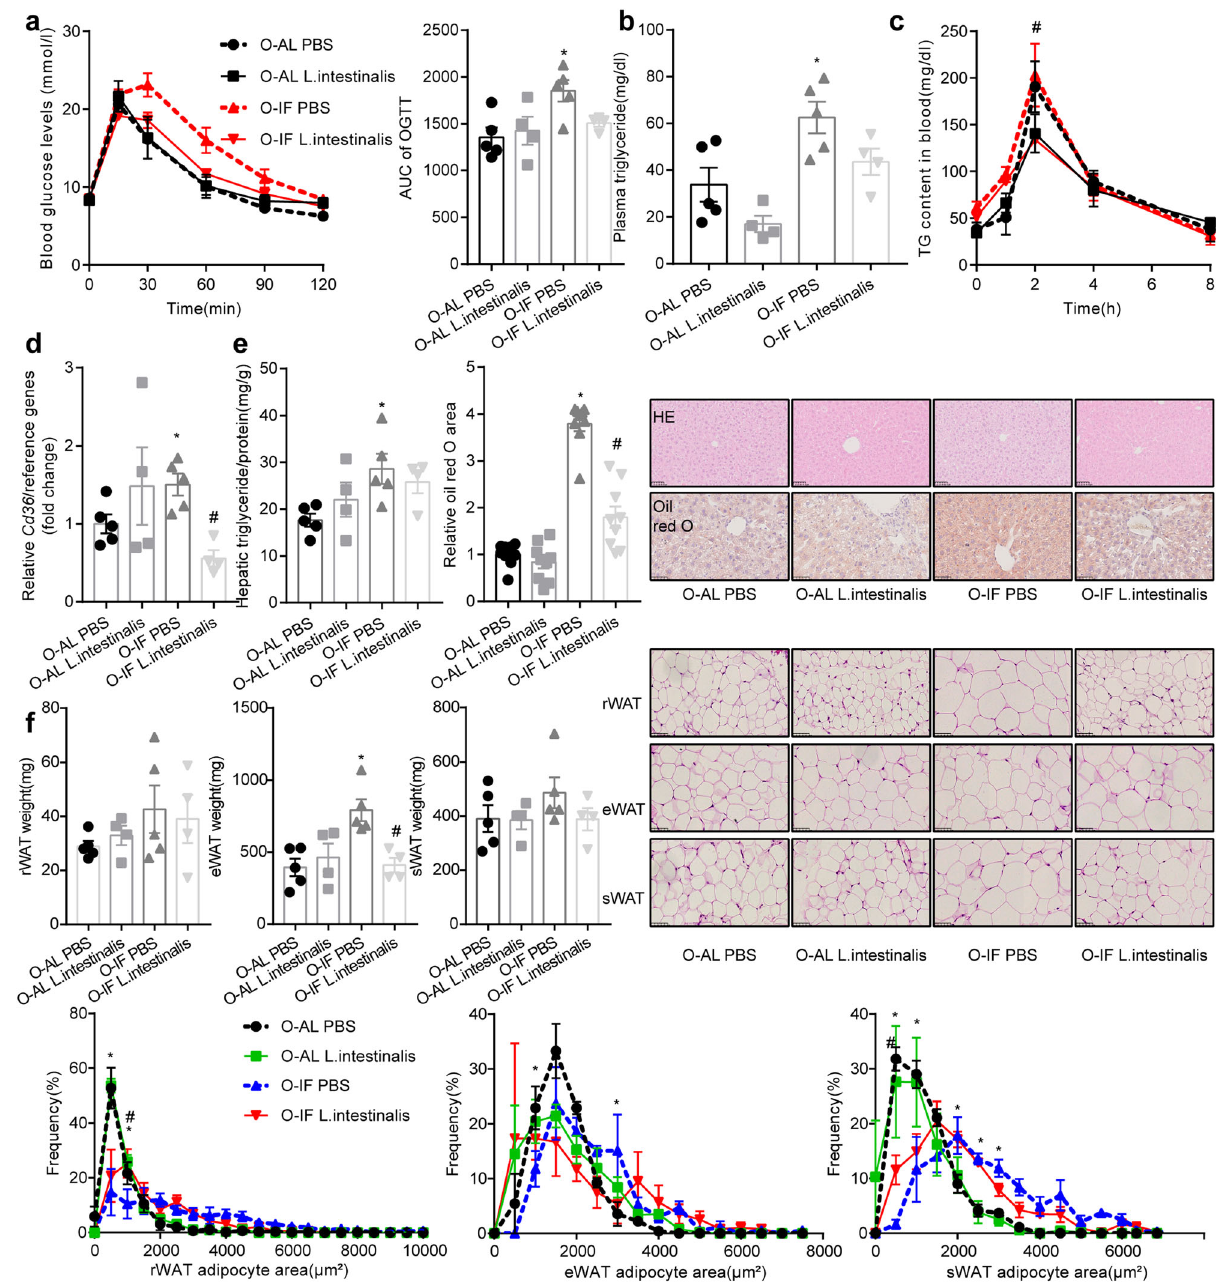
Fig. 4 Lactobacillus_intestinalis improves glucose and lipid metabolism in offspring of maternal intermittent fasting mice. Lactobacillus_intestinalis at a dose of 2 × 10 8 CFU/day were orally gavaged to O-AL or O-IF mice for 10 weeks. Results were expressed as mean ± SEM. Two-way ANOVA was used for comparisons between multiple groups. * P < 0.05 vs. O-AL PBS. # P < 0.05 vs. O-IF PBS. N = 5 for O-AL PBS, 4 for O-AL L. intestinalis , 5 for O-IF PBS, and 4 for O-IF L. intestinalis . a Glucose tolerance test and the area under curve. b Plasma TG levels. c Levels of circulating triglyceride in response to oral administration of olive oil. N = 4. d mRNA levels of CD36 , which were determined by real-time quantitative PCR and normalized to the geometric mean value of reference genes ( Hprt, Rpl32 and Tbp ). e Lipid contents and steatosis in liver. f Fat mass, H&E staining and adipocyte size in rWAT, eWAT and